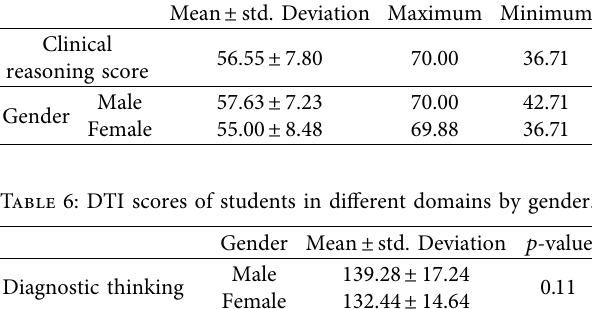
Table 2: Frequency of DTI score levels of students.